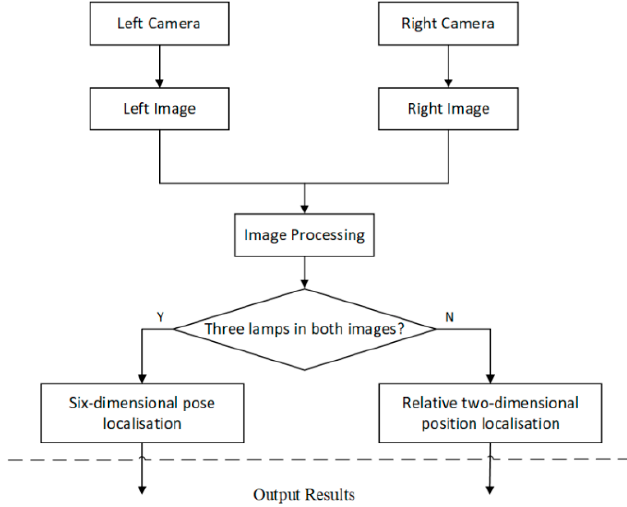
Figure 3. Flow chart of the visual localisation algorithm.